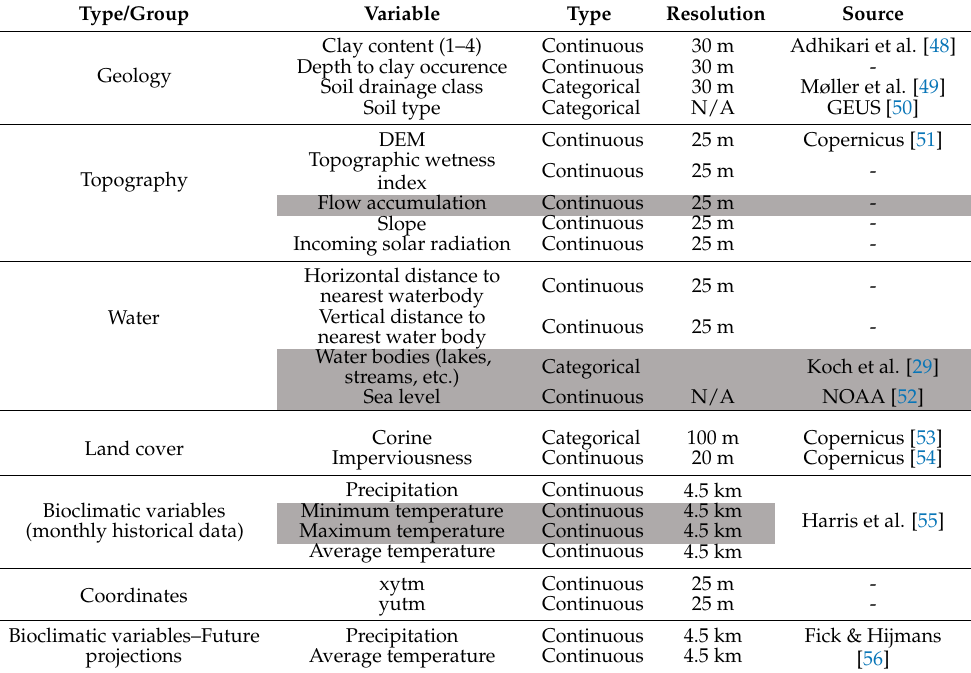
Table 1. Data collected for the study. Variables not used for training/testing the final ML models are marked in